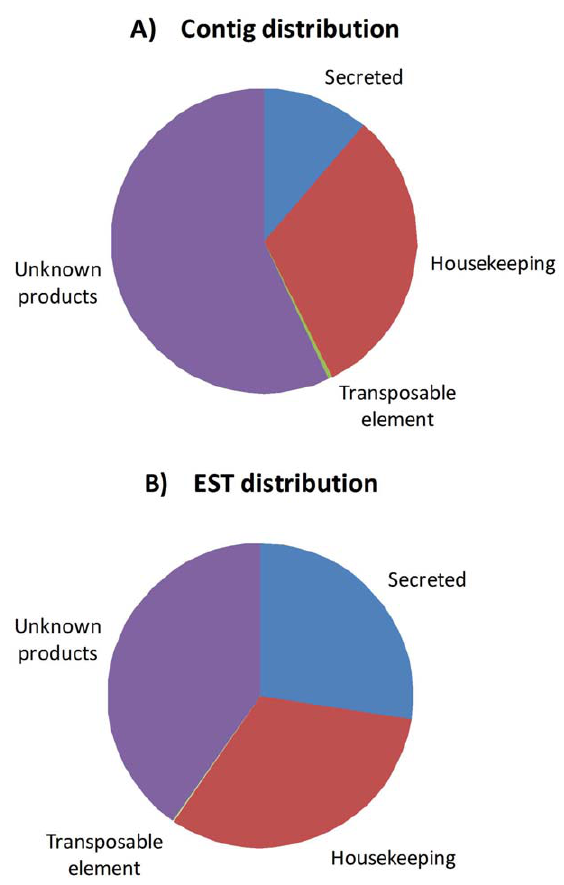
Figure 1. Cat flea sialotranscriptome. Distribution of assembled contigs (A) and number of expressed sequence tags (ESTs) (B) in the sialotranscriptome of the cat flea, Ctenocephalides felis .